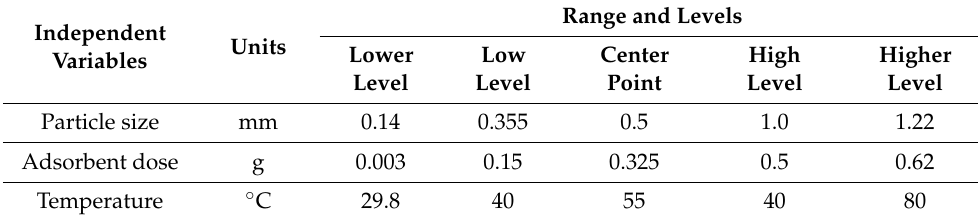
Table 1. Experimental